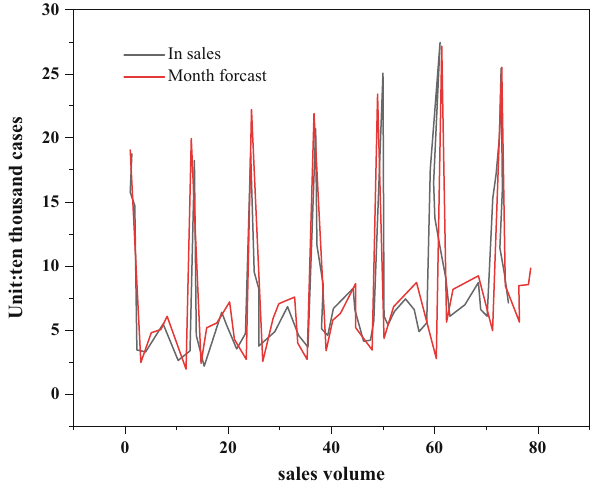
Figure 6: Comparison of the e ff ect of the monthly sales